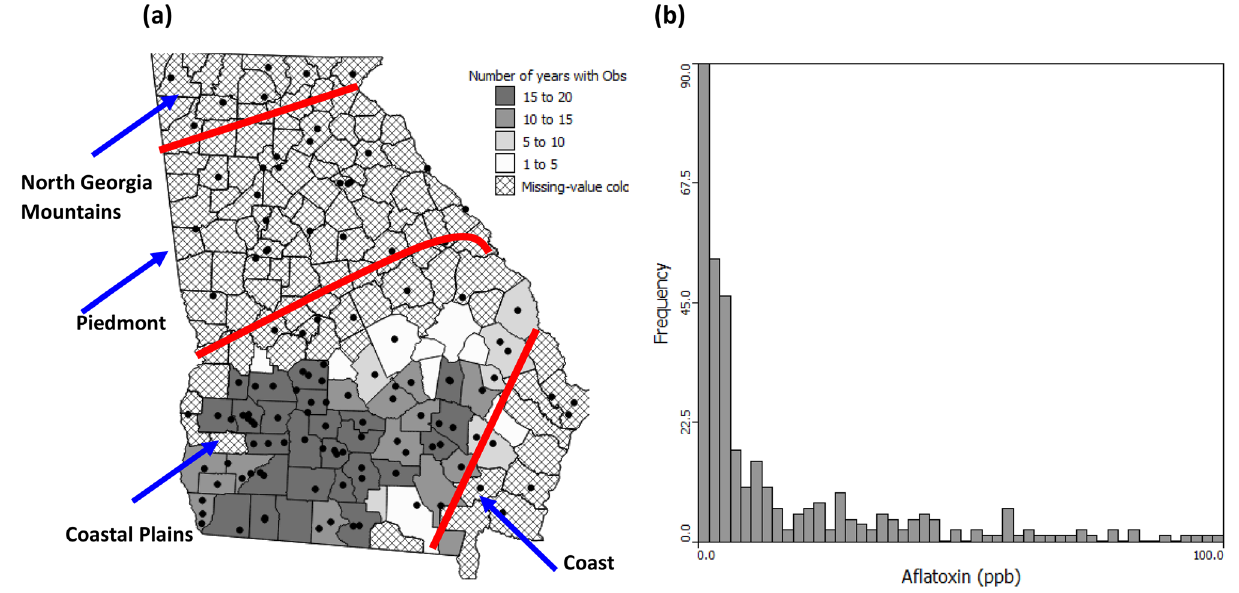
of county level Aflatoxins values < 100 ppb for southern Georgia, USA, 1977–2004, 61 observations (not shown) were between 100 and 4807